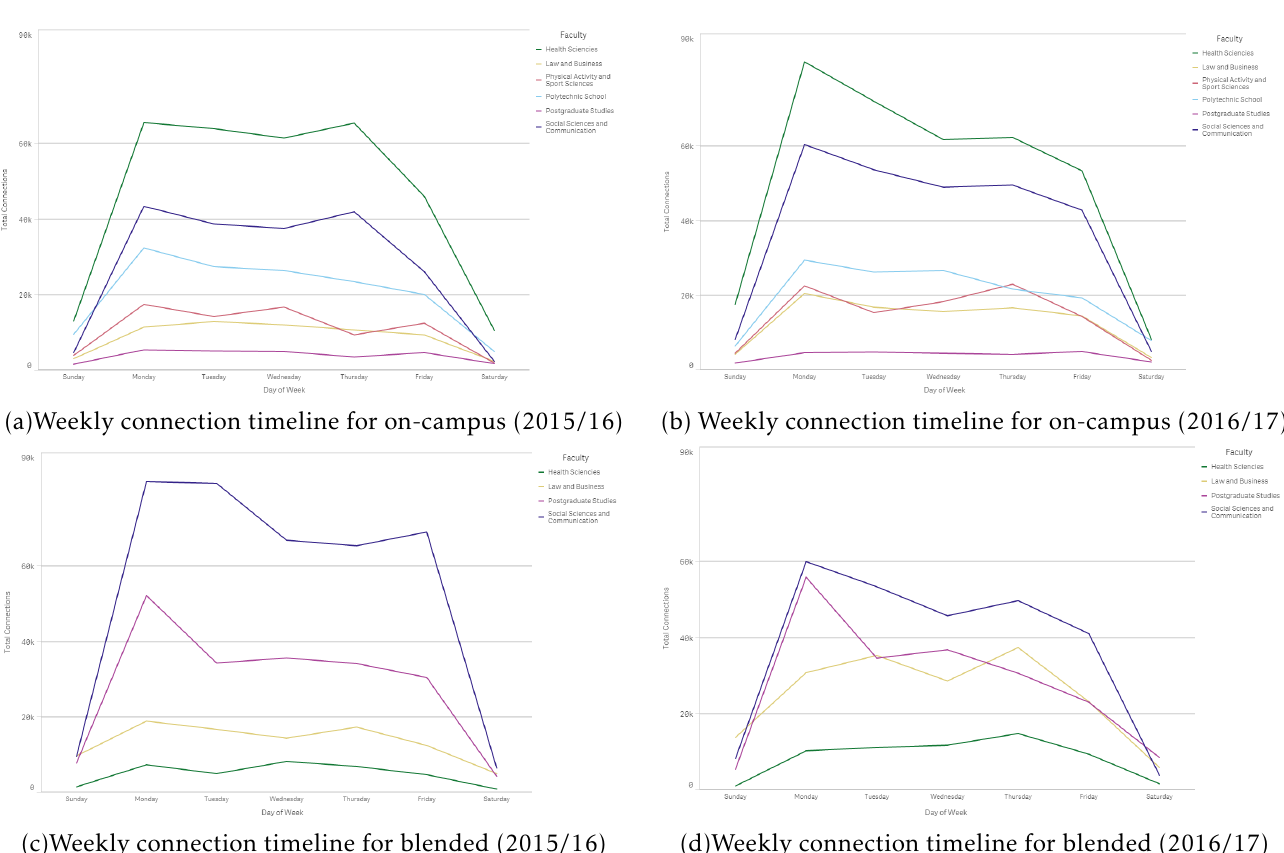
Figure 7. Weekly trends in lecturers’ log-ins for faculties with on-campus and blended